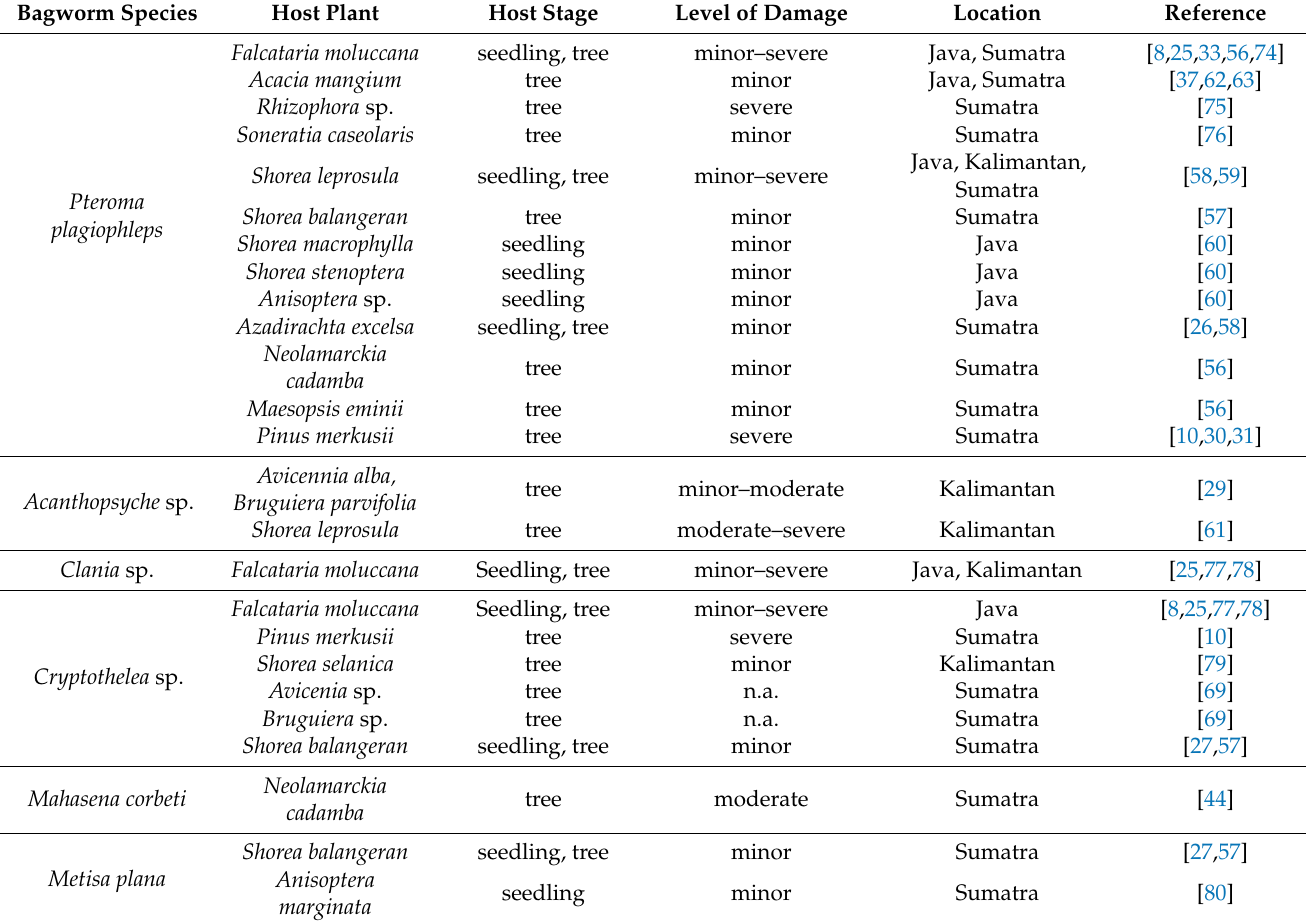
Table 2. List of bagworm species associated with Indonesian forest